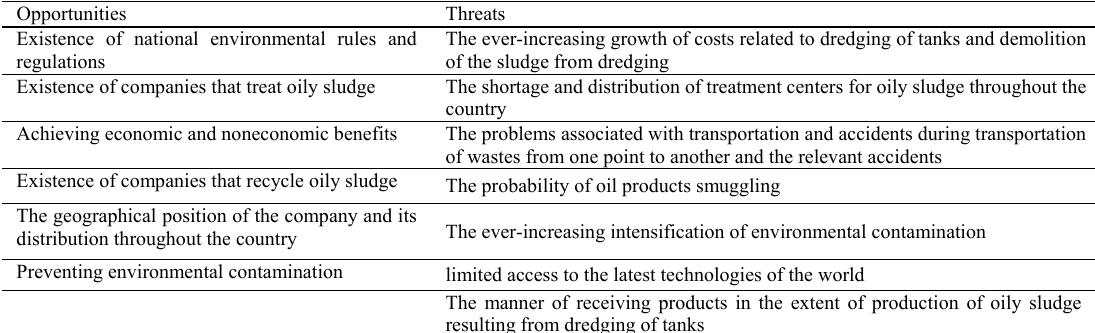
Table 1: Matrix of evaluation of external factors Threats Opportunities